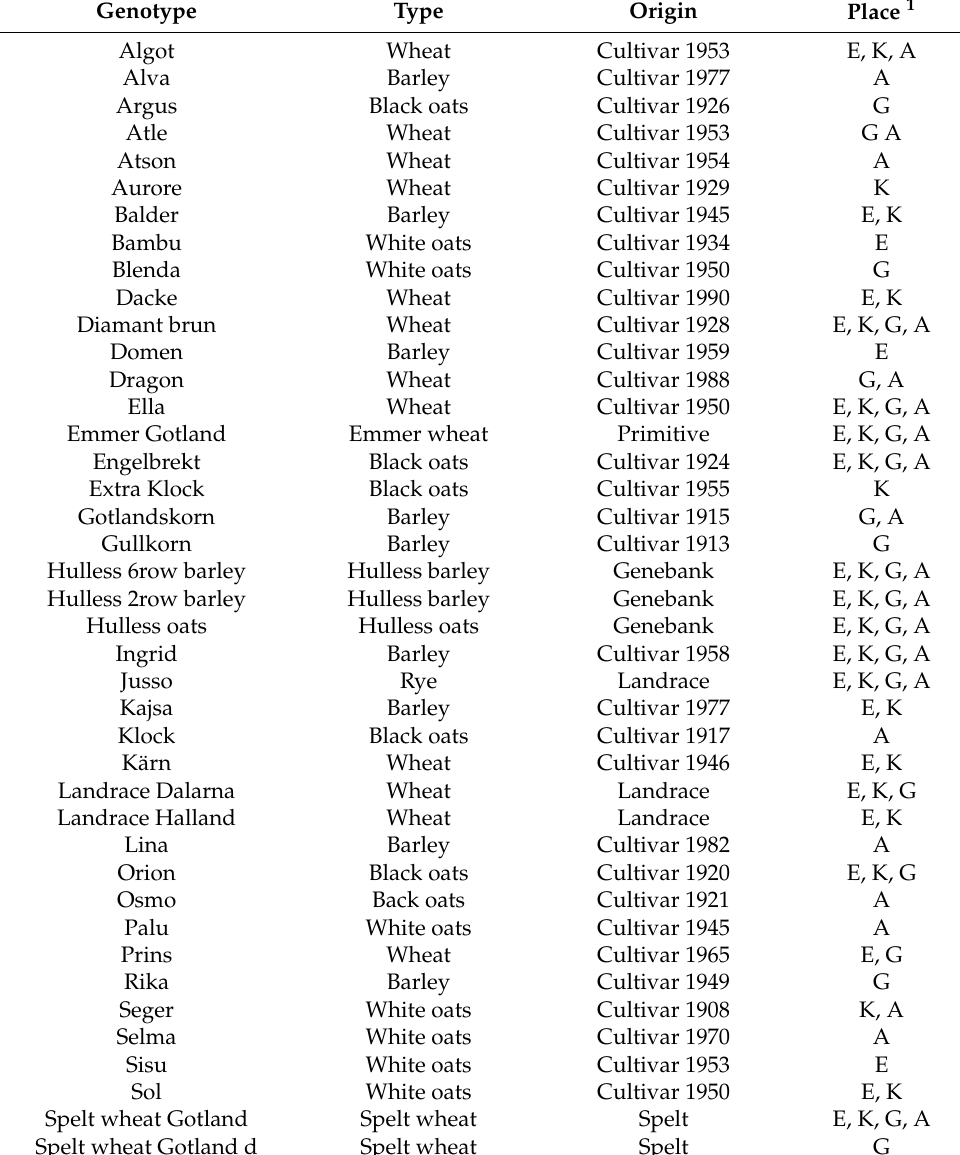
Table 1. Name, type, origin and place of cultivation of genotypes used in the present